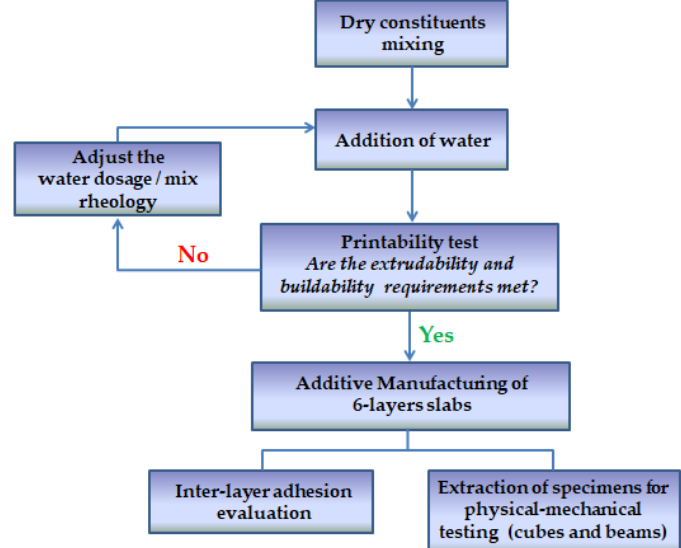
Figure 4. Manufacturing and printability testing of rubber-cement mixtures: experimental procedure.